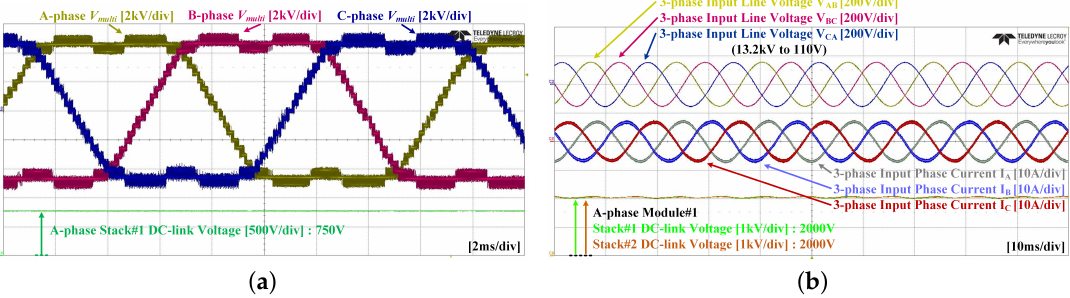
Figure 12. Experimental results of cascaded NPC AC/DC converter: ( a ) multi-level waveform at 3-phase 6.6 k V ac grid line voltage; ( b ) steady-state waveform under 120 kW load